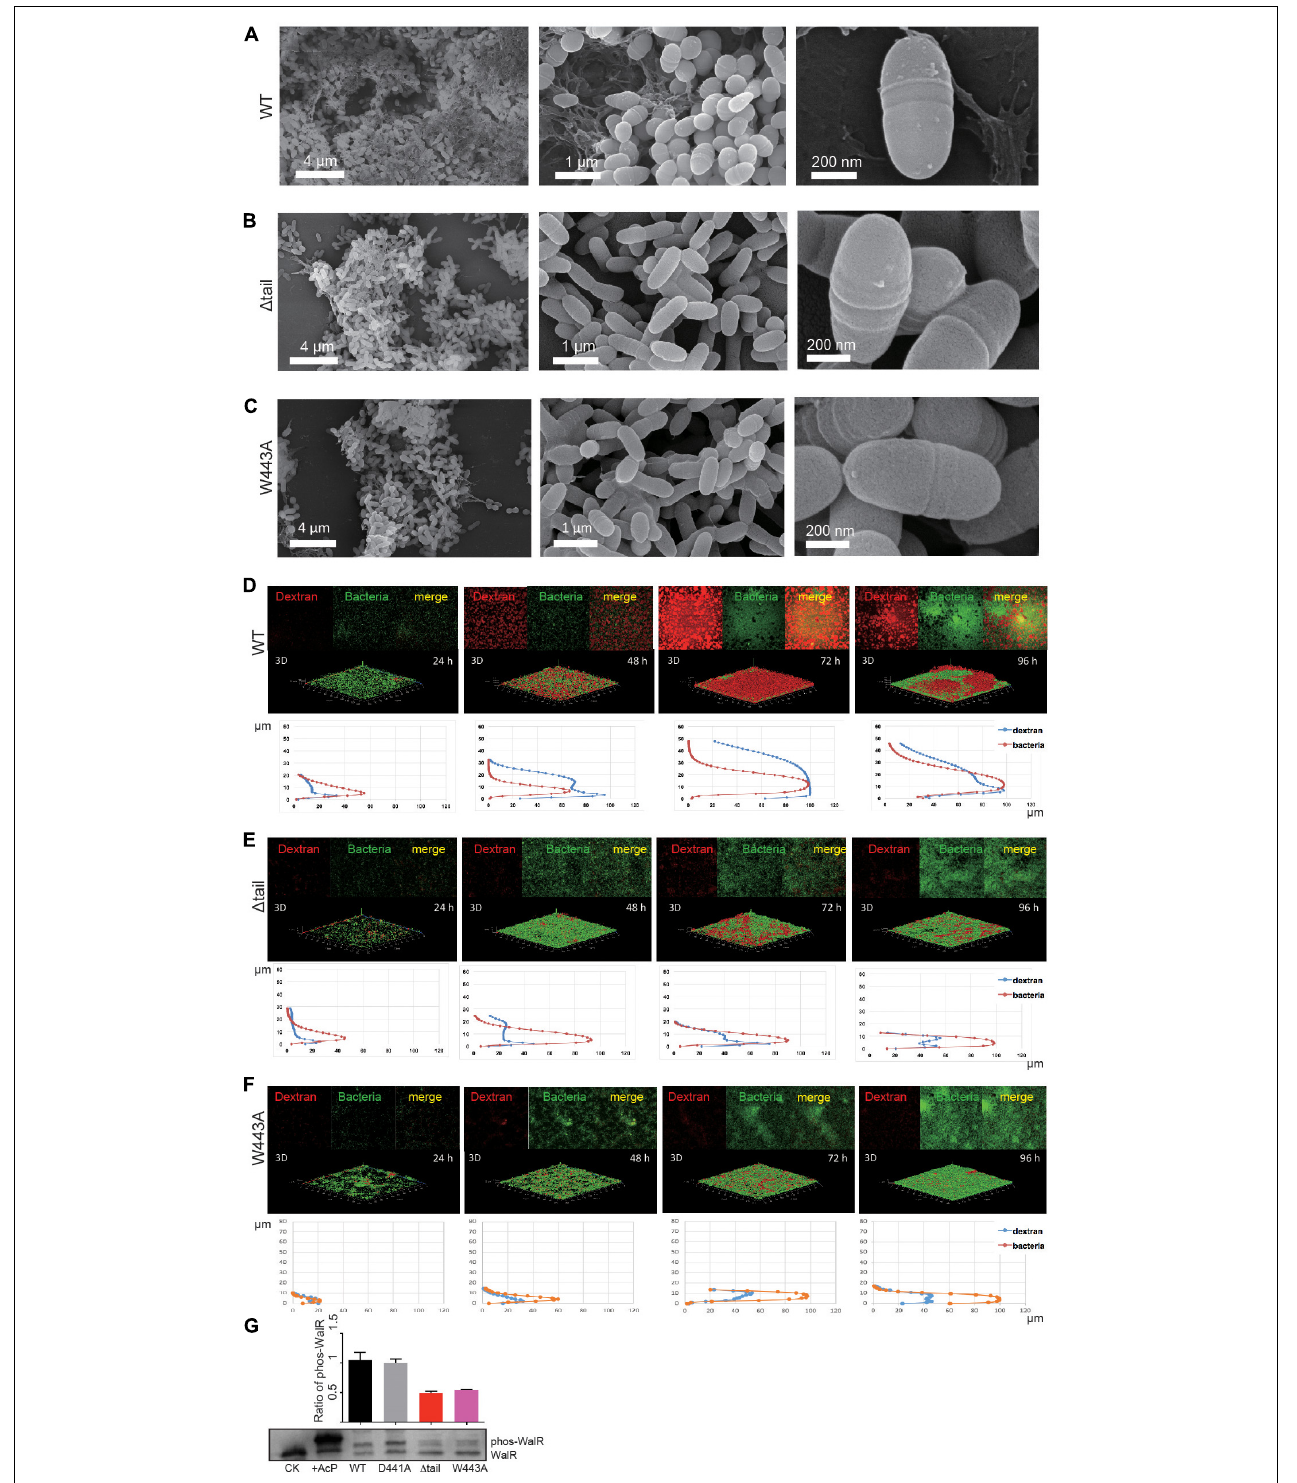
FIGURE 5 | Effect of WalK mutations on biofilm development of S. mutans . (A–C) SEM analyses of mature biofilms grown for 72 h. (D–F) Quantification of biofilms by fluorescent staining. All biofilms were quantified for their thickness and horizontal growth shown below each 3D image. (G) Phosphorylation state of WalR in vivo . Phosphorylated WalR was separated from its non-phosphorylated state in a Phos-tag gel and detected using an anti-WalR antibody. The non-phosphorylated (CK) and phosphorylated WalR (His-tagged, treated with AcP) were loaded in the first two lanes. The cytoplasmic phosphorylation ratio of WalR shown in the bar chart was determined by band intensities and averaged from three independent experiments with error bars showing standard deviation.